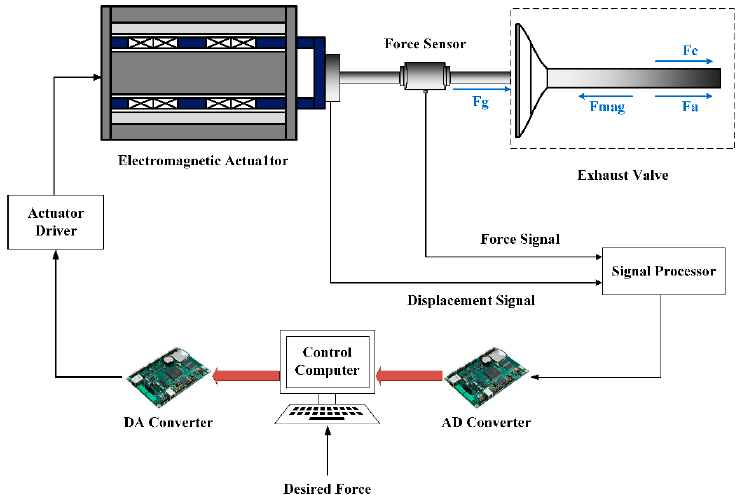
Figure 1. Schematic diagram of the electric load